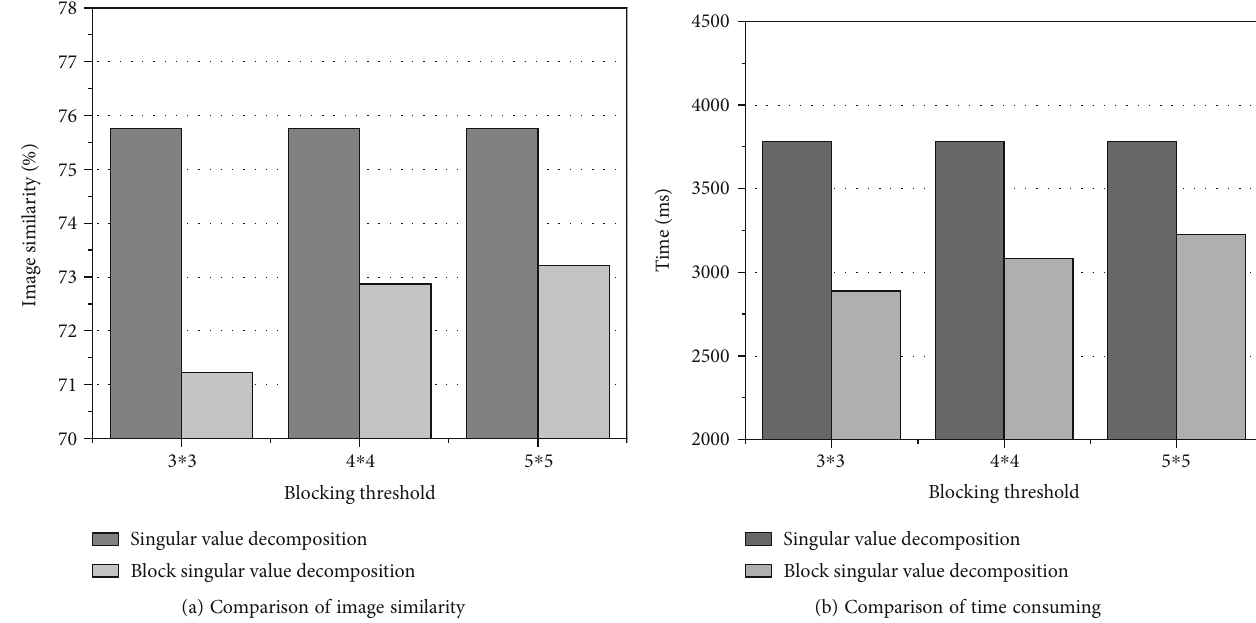
Figure 5: Comparison between original image and enhanced